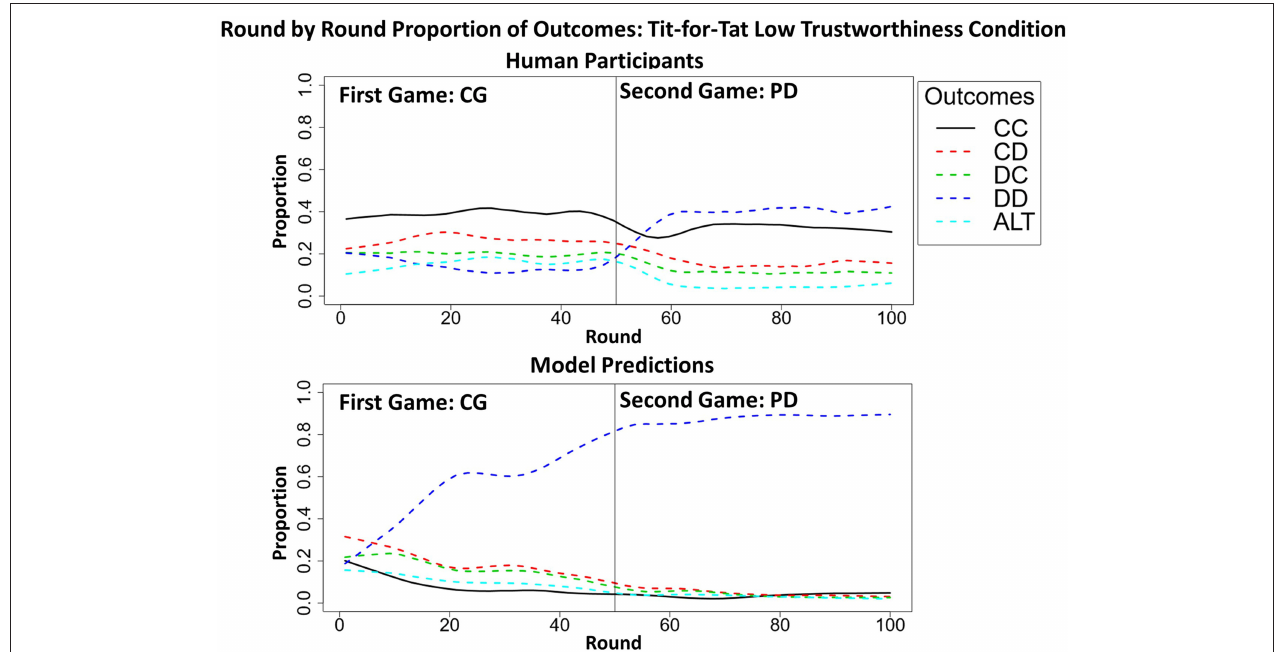
FIGURE 9 | The round-by-round proportion of all five outcomes [i.e., mutual cooperation (CC), unilateral cooperation (CD), unilateral defection (DC), mutual defection (DD), and alternation (ALT)] of both the model and participants during the CGPD Tit-for-Tat low trustworthiness condition, highlighting the surface transfer effect from CG to PD with the mutual cooperation outcome (thick black line) in the human data which was absent in the model’s predictions. All of the overall round-by-round proportions were smoothed by using the loess function in R (smoothing parameter of 0.2), to remove some of the round-by-round variability.